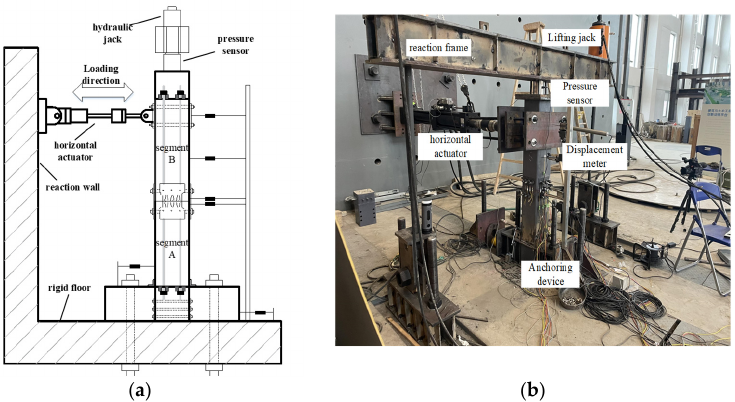
Figure 8. Schematic layout of loading and testing apparatus for the proposed static test, ( a ) Schematic diagram of loading device, ( b ) Test loading device diagram.